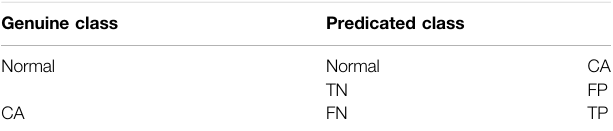
TABLE 7 | Matrix of confusion.